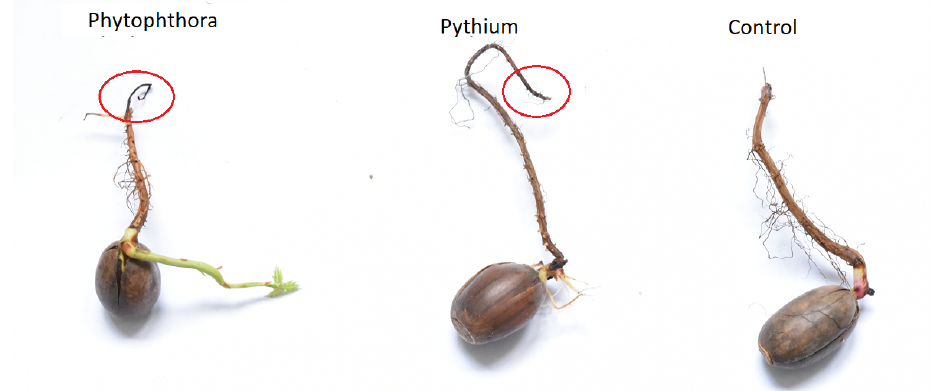
Figure 1. Examples of measured samples of three considered categories: Healthy acorn (Control), acorn infected by Phytophthora , acorn infected by Pythium . Tissue necrosis can be distinguished from healthy regions in infected